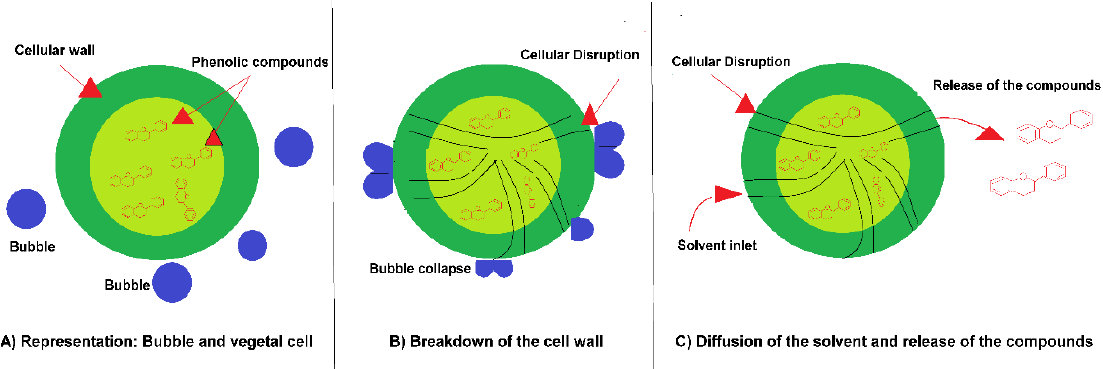
Figure 3. Graphical representation of cavitation-bubble collapsing and releasing plant material in three steps. ( A ) Bubble and vegetal cell representation, ( B ) Breakdown of the cell wall and bubble collapse, finally ( C ) Diffusion of the solvent through the cellular disruption and release of the compounds. Modified from Shirsath et al. [22] .